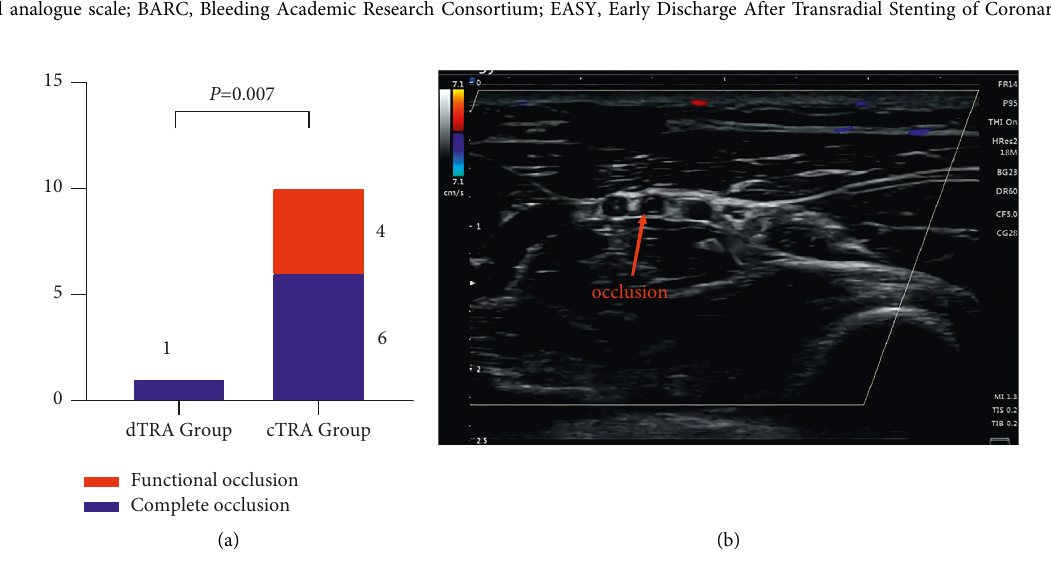
Figure 4: (a) Results of ultrasound follow-up. (b) Ultrasound image of complete radial artery